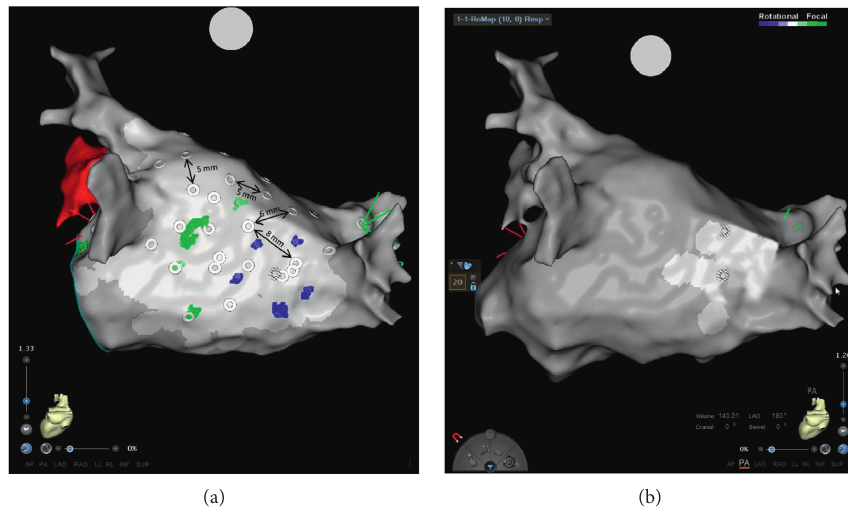
Figure 5: (a) High-density mapping performed with the 3D CARTO 3 V7 system and bipolar PentaRay ™ NAV Catheter (Biosense Webster), to research, during AF, rotational (Ras), and focal activities (FA). The green squares indicate the FAs, while the blue squares indicate the RAs. A repetitive RA is clearly visible between the posterior and the inferior wall of the left atrium, involving a large area (calculated at 4.2cm 2 ), which is more compatible with a real rotor (macroreentrant driver rather than a microreentrant one). Positioning the PentaRay in the same spot at different times (white circles with a distance of ≤ 1mm), we reproduced the left atrium identically. The ablation was directed to the treatment of the RAs. In (b), after RF application on the entire rotor seat area, the left atrium mapping during fibrillation demonstrates its complete disappearance (FIRM approach). The procedure was completed with PVI and synchronized electrical car- dioversion. No AF recurrence at 12-month